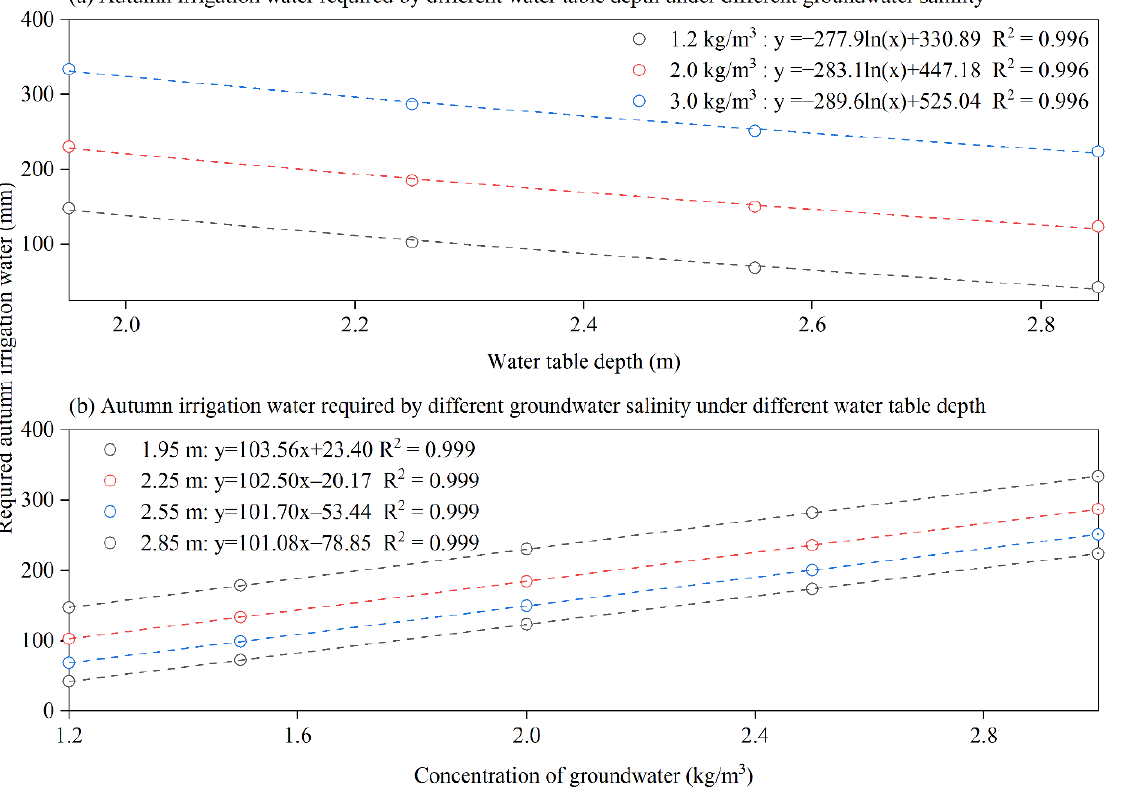
Figure 13. The relationship between water table depths, groundwater salinity and required autumn irrigation water to sustain root zone within a mild salinity level (0.3 kg/100 kg) in the well-irrigated area.